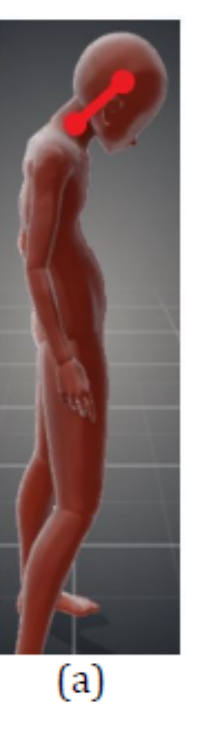
Figure 3. (a) Kyphosis and (b) left shoulder tilted